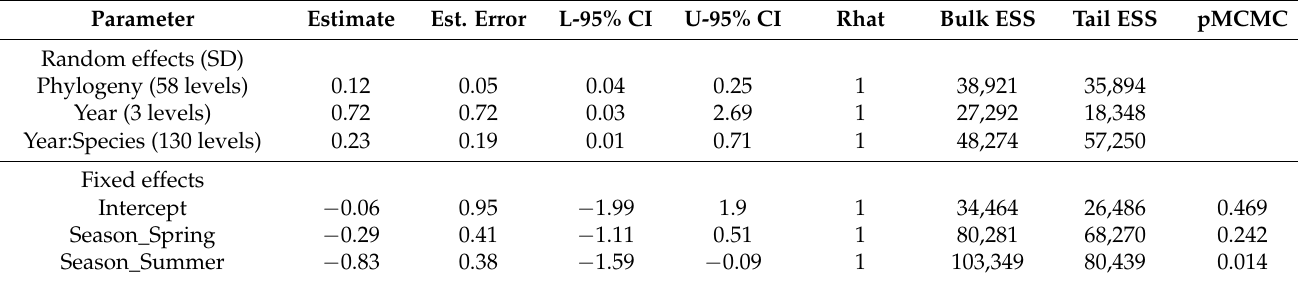
Figure 5. Intensity and prevalence of haemosporidian infection for the entire avian community in Drienovec, Slovakia, during 2017, 2018 and 2019. Plots show ( A ) the relationship between parasite intensity and time of year and ( B ) differences in infection prevalence between spring, summer, and autumn. Table 6. Bayesian multivariate multilevel model on the predictors of haemosporidian infection prevalence in a local avian community in Drienovec, Slovakia , during 2017, 2018 and 2019.